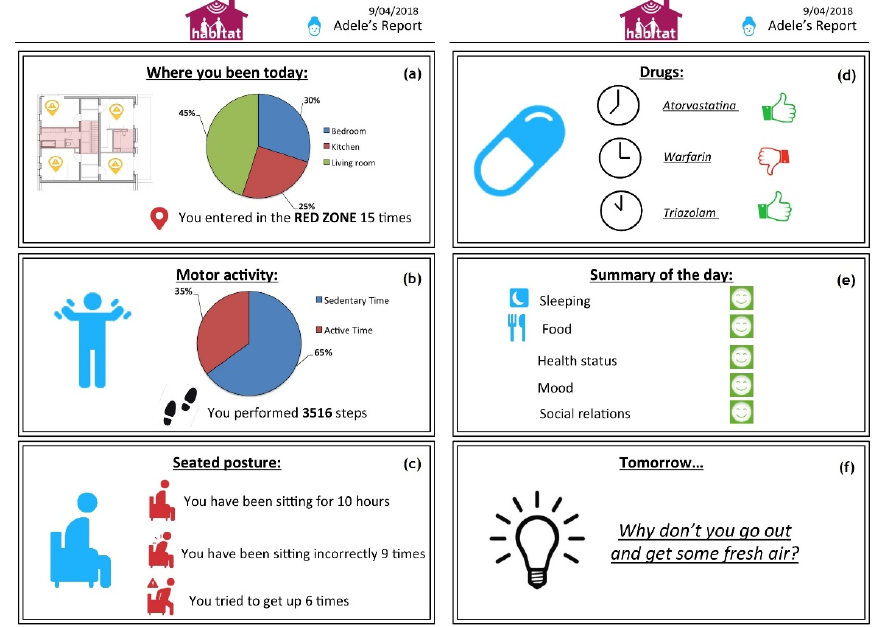
Figure 11. Real and estimated positions for the points of ( a , b ) minimum and ( c , d ) maximum reader-tag distance (mean and point cloud); the active tag is positioned on the chest of the user.